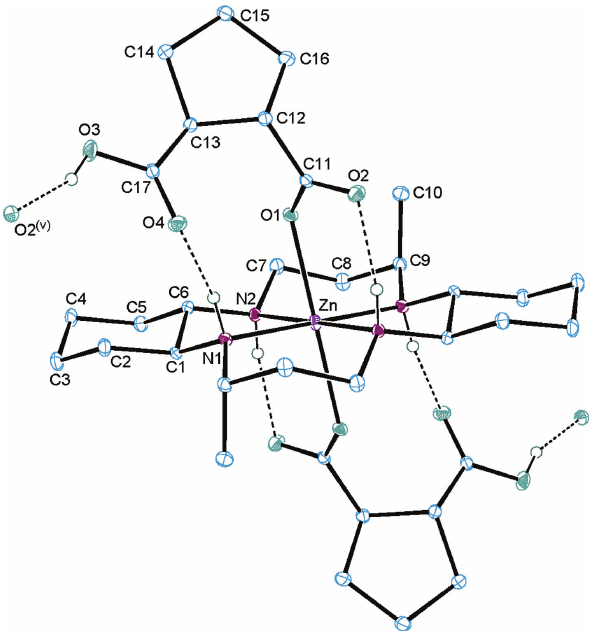
Figure 1 An ORTEP drawing (30% probability ellipsoids) of [Zn(L) (Hcpdc) ] ( 1 ) with the atomic numbering scheme. 2 The hydrogen bonds are shown as dashed lines.